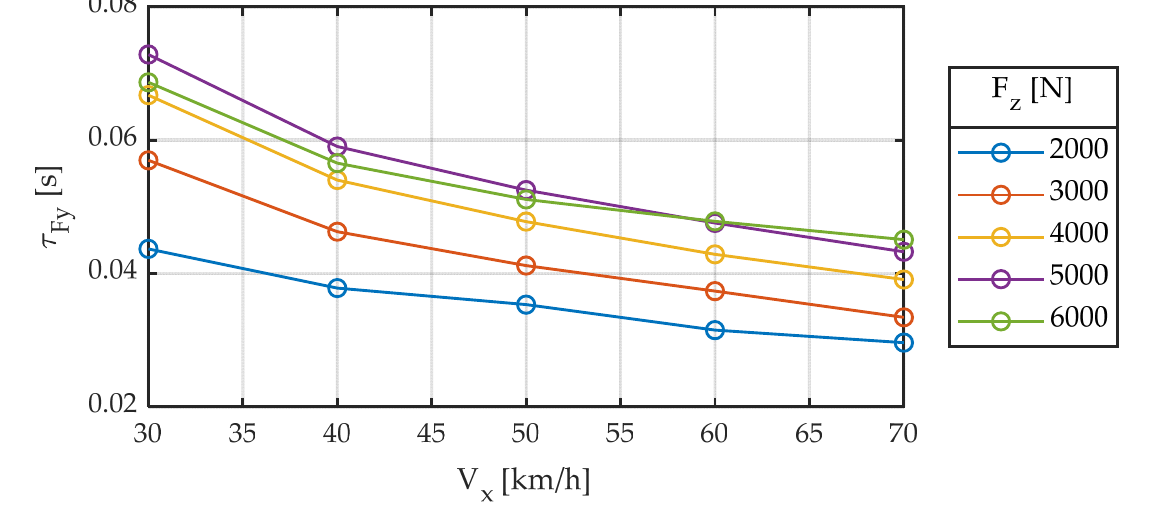
Figure 8. Relaxation time constant for different vertical loads. Slip angle sweep ± 2 ° . Frequency 1.0 Hz.